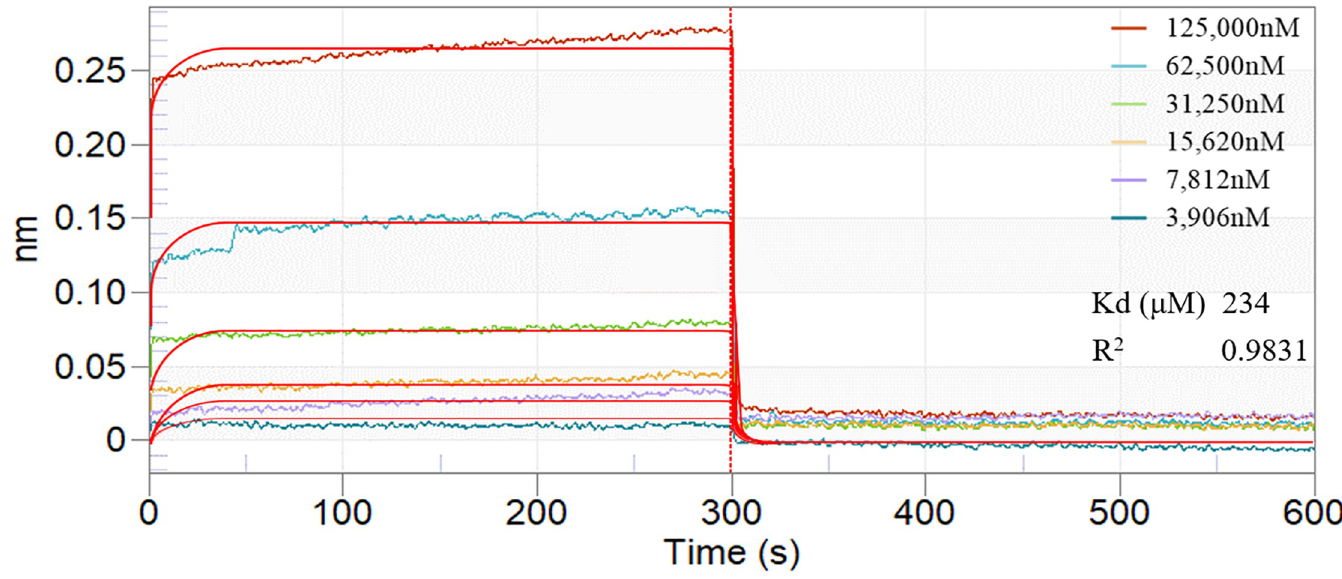
Fig 6. Kinetic analysis by BLI of the binding of ISL to